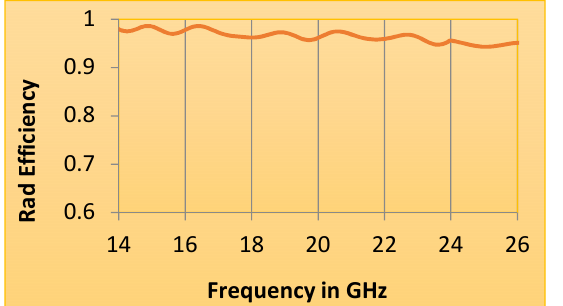
FIG. 7. RADIATION EFFICIENCY